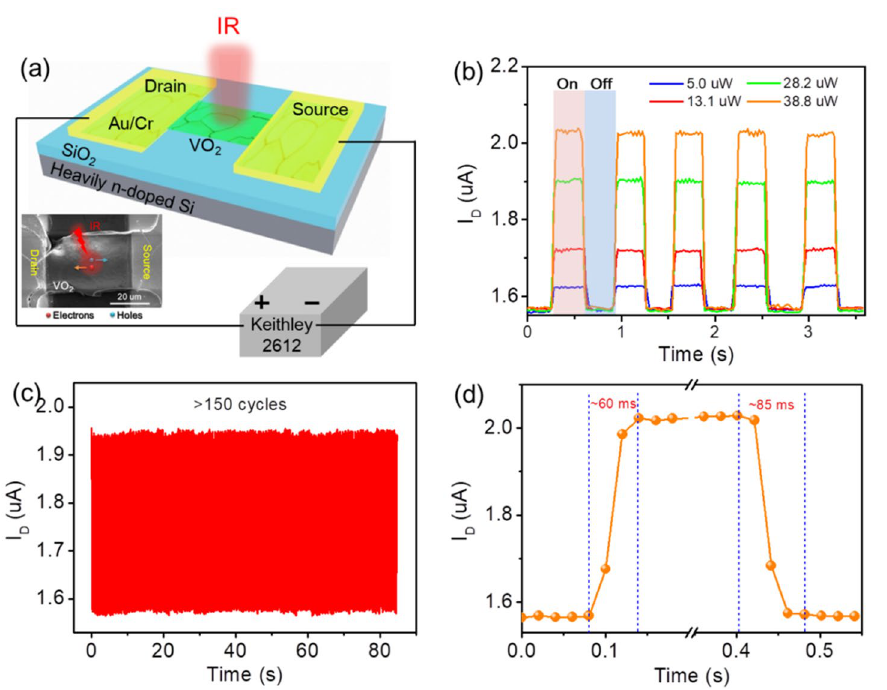
Figure 5. (a) Schematic diagram and SEM image of the VO 2 film IR (850 nm) photodetector. (b) Photoswitching characteristics of the IR photodetector under varying light power. (c) Repeated photoswitching characteristics of the IR photodetector with more than 150 cycles. (d) A single on/off cycle for estimating the rise and fall